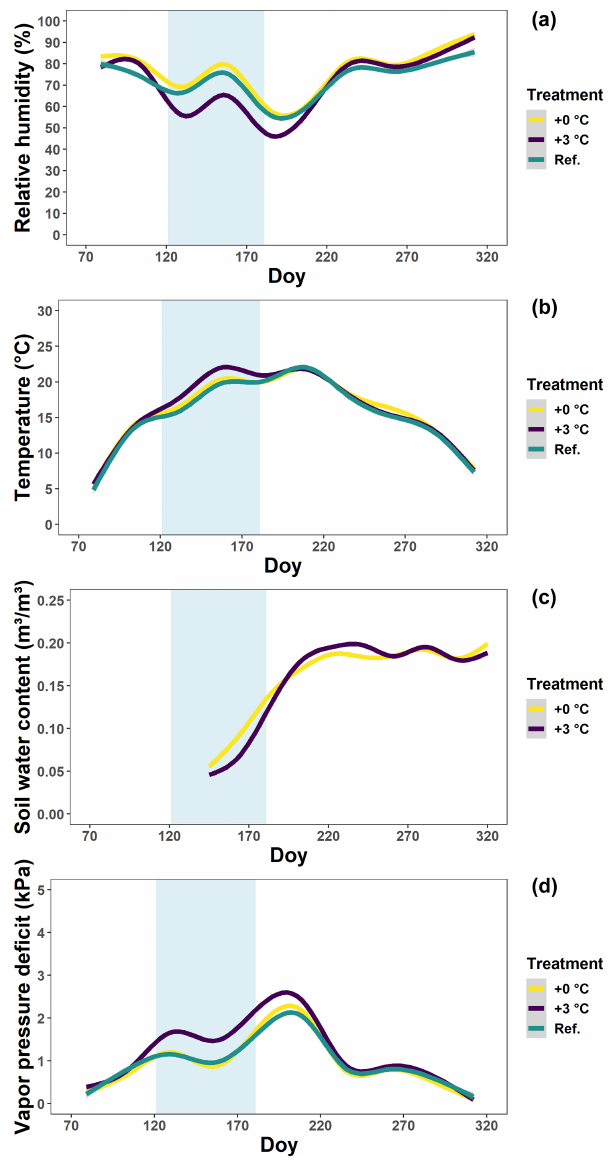
Figure 1. The relative humidity (a) , temperature (b) , soil water con- tent (c) and vapor pressure deficit (d) in the glasshouses and outside plots at the Drie Eiken Campus in Wilrijk. Solid lines represent re- gressions of half-hourly measurements of the relative humidity (%), temperature ( ◦ C) and soil water content (m 3 /m 3 ). Regressions were performed using generalized additive models implemented by the geom_smooth argument in the R ggplot2 package. The vapor pres- sure deficit (kPa) was calculated using the formulas of Buck (1981) using data of the relative humidity and air temperature between 07:00 and 19:00CET. Green, yellow and purple lines represent the conditions in the reference plots (Ref.), glasshouses that follow the outside ambient air temperature ( + 0 ◦ C) and glasshouses that are 3 ◦ C warmer than the outside ambient air temperature ( + 3 ◦ C), re- spectively. The light blue band represents the